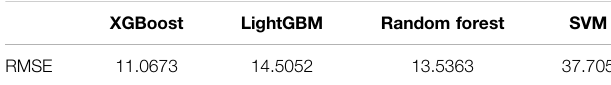
TABLE 3 | Evaluation of prediction accuracy (RMSE).